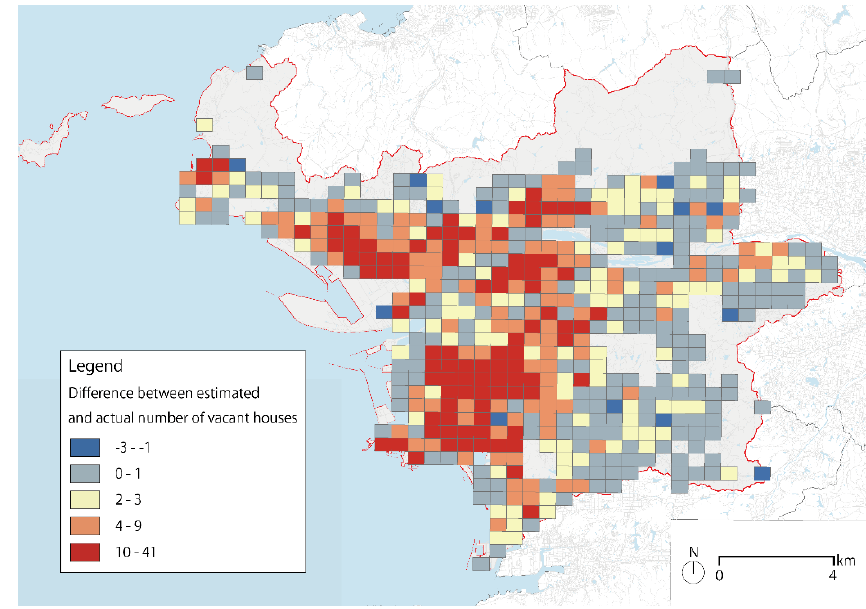
Figure 3. Geographical distribution of vacant houses subtracted from estimated ones per 500-meter grid